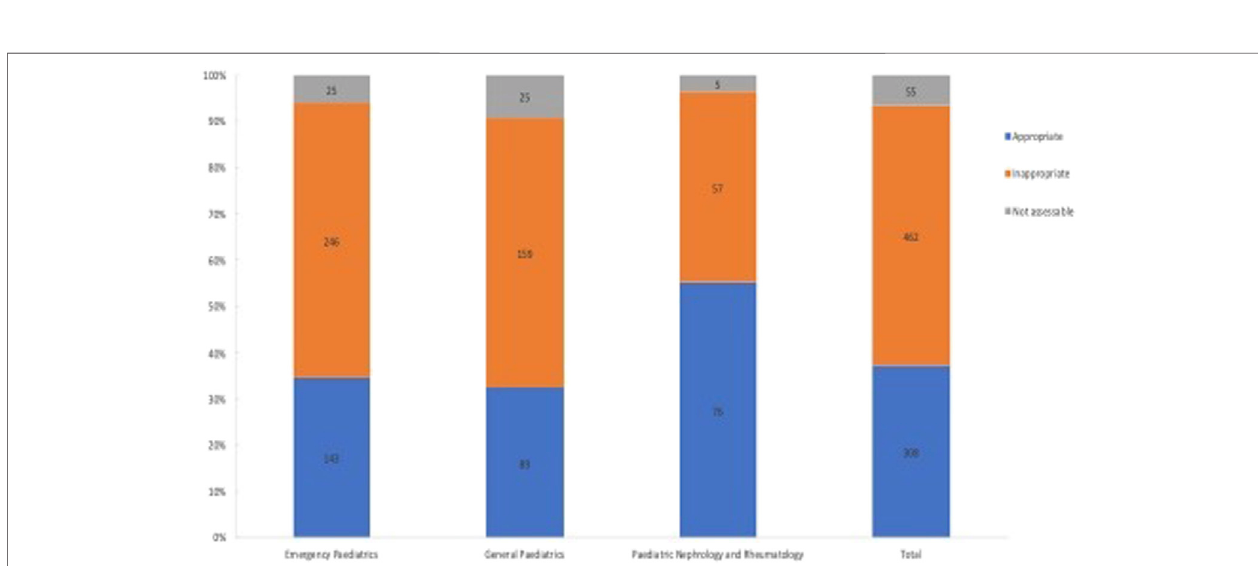
FIGURE 2 | Distribution of appropriateness strati fi ed by paediatric subspecialties.